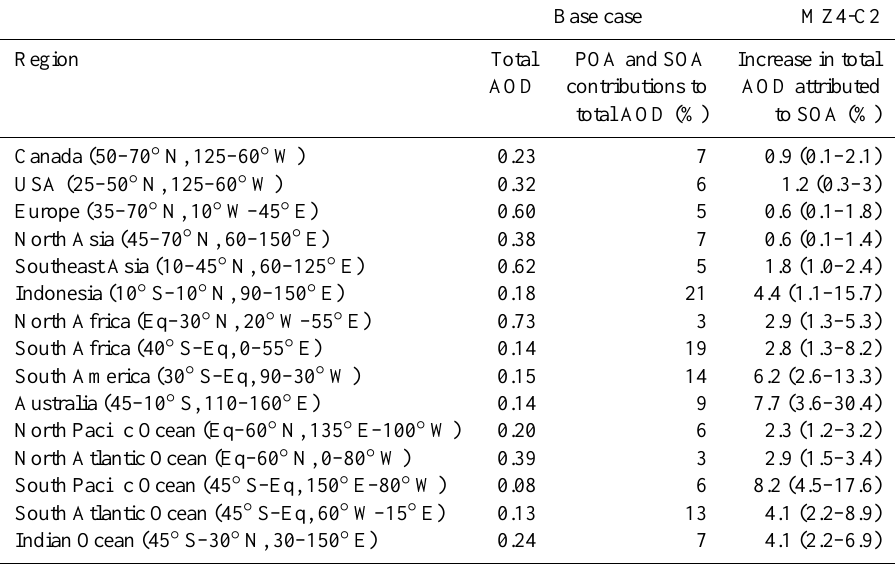
Table 5. Regionally averaged base-case annual AOD and its increases due to additional SOA predicted by the updated version of MOZART-4 (MZ4-C2). Also, shown in parenthesis, is the range of monthly average increase in total AOD due to SOA. Base case MZ4-C2 Region Total POA and SOA Increase in total AOD contributions to AOD attributed total AOD (%) to SOA (%) Canada (50–70 ◦ N, 125–60 ◦ W) 0.23